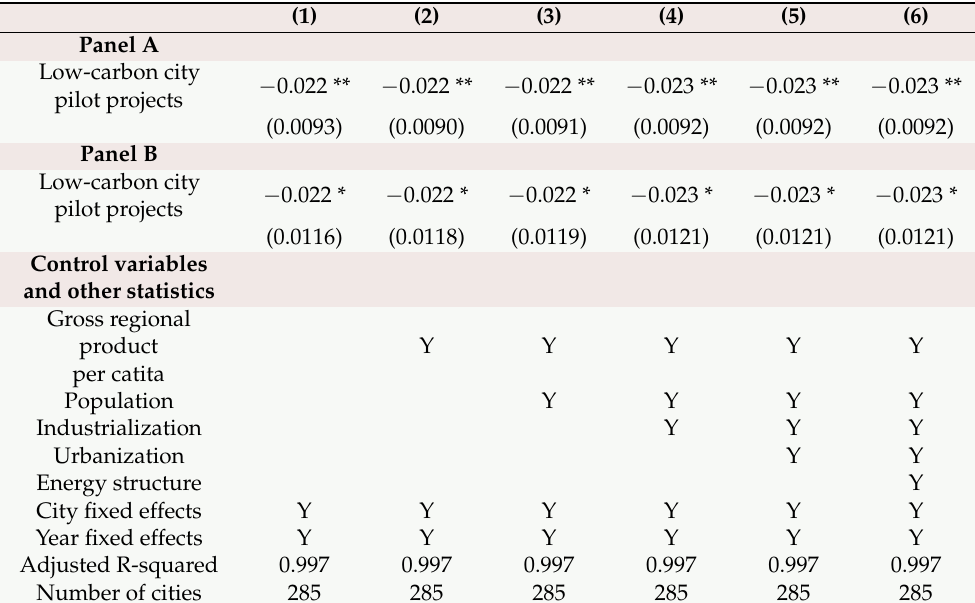
Table 1. Estimates in the impact on carbon from difference-in-differences